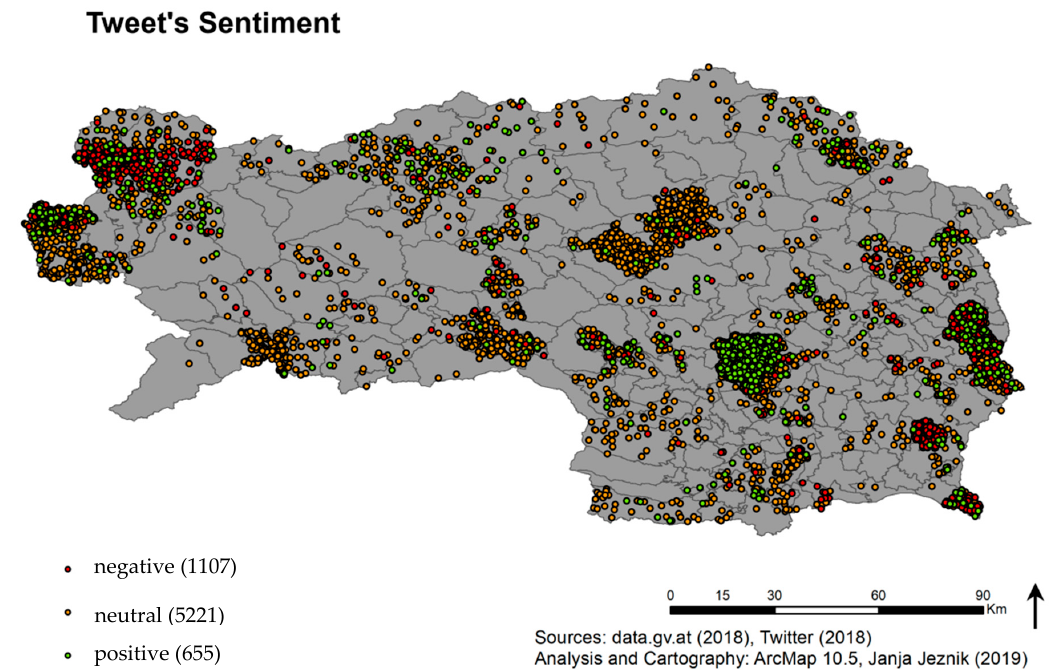
Figure 9. Results of the sentiment analysis. Basically, there are 1107 negative tweets (marked as red dots), 5221 neutral tweets (orange dots) and 655 positive tweets (green dots). The tweets with negative sentiment are also a result of German place names that start with “Bad …”, denoting spa towns. The algorithm flags the German “Bad …” with the meaning of the English word “bad”.